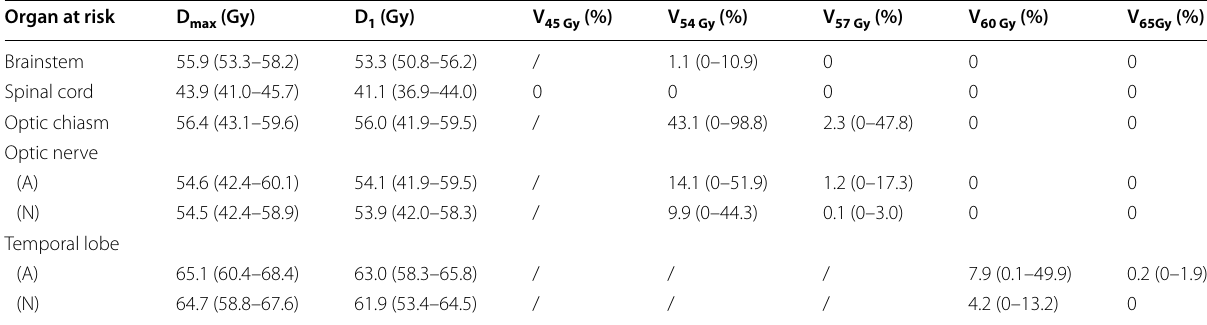
All values are presented as mean followed by range in parentheses